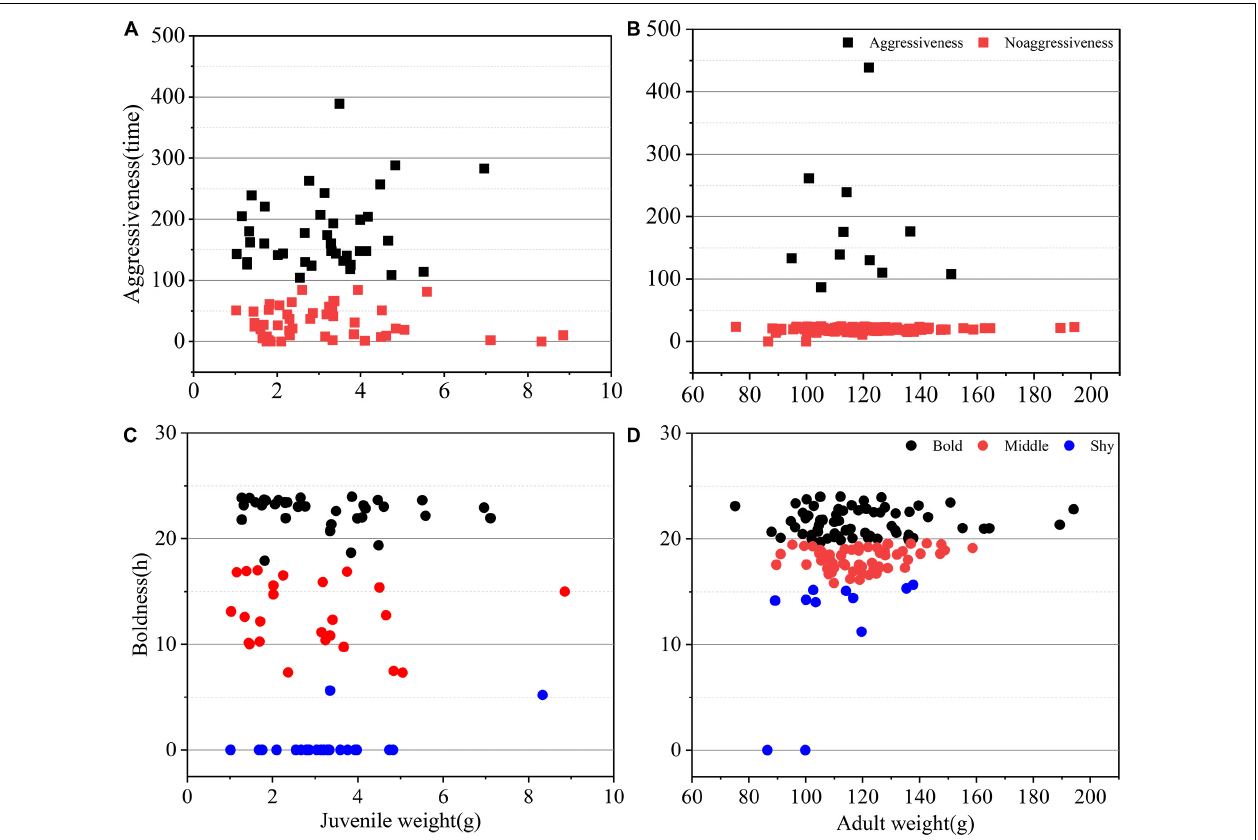
FIGURE 3 | Personality distribution of boldness and aggressiveness in juvenile and adult crabs. (A) Aggressiveness distribution of juvenile crabs and (B) adult crabs. (C) Boldness distribution of juvenile crabs. (D) Adult crabs. Different colors represent different personality levels of crabs. Different shapes represent different personalities, squares represent aggressiveness, and circles represent